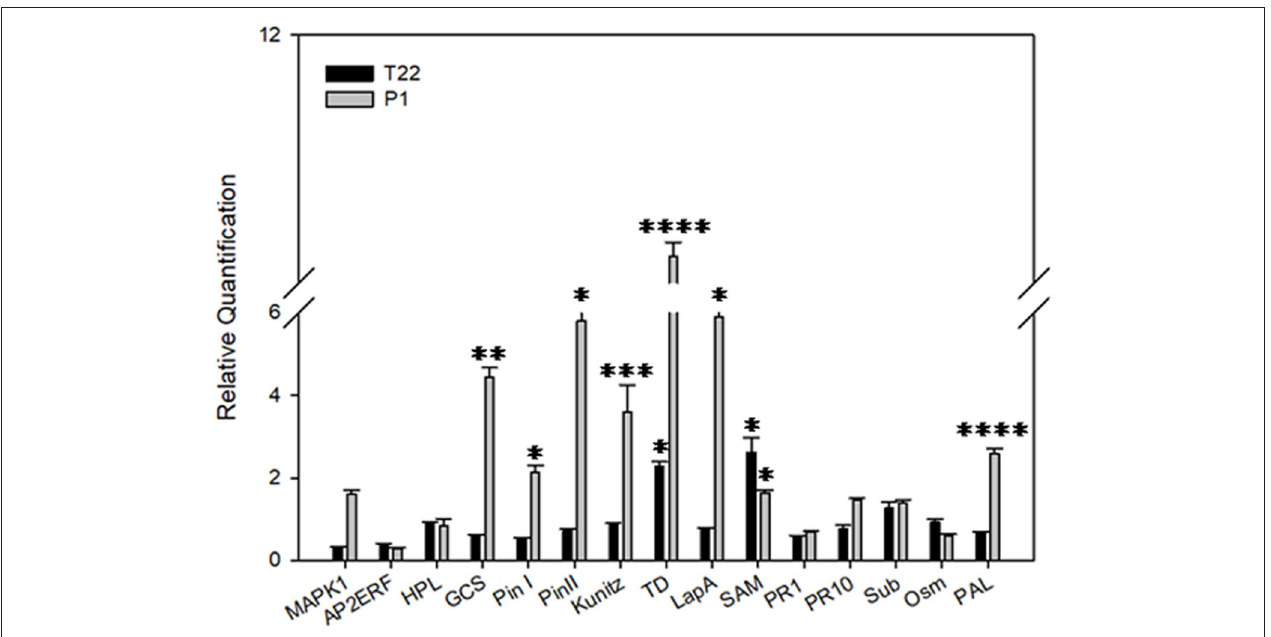
FIGURE 11 | Relative quantification of defense-related genes by real-time PCR (RT-PCR). Relative quantities (RQ) of defense genes in plants treated with T. afroharzianum T22 and T. atroviride P1 at 20 ◦ C. Data are calibrated to the untreated control sample (RQ = 1). Bars represent SE. Asterisks indicate statistically significant differences compared to the control condition (Student’s t -test, * P < 0.05; ** P < 0.01; *** P < 0.001; **** P < 0.0001). MAPK1 , Map Kinase 1; AP2ERF , Ap2 Ethylene responsive factor; HPL , hydroperoxide lyase; GCS , germacrene C-synthase; Pin I and Pin II, wound-induced proteinase inhibitor I and II; Kunitz, Kunitz type proteinase inhibitor; TD , Threonine deaminase; LapA , leucine aminopeptidase A; SAM, S-adenosyl methionine; PR1-PR10 , pathogenesis-related proteins 1 and 10; Sub , Subtilisin; Osm , Osmotin; PAL , Phenylalanine ammonia